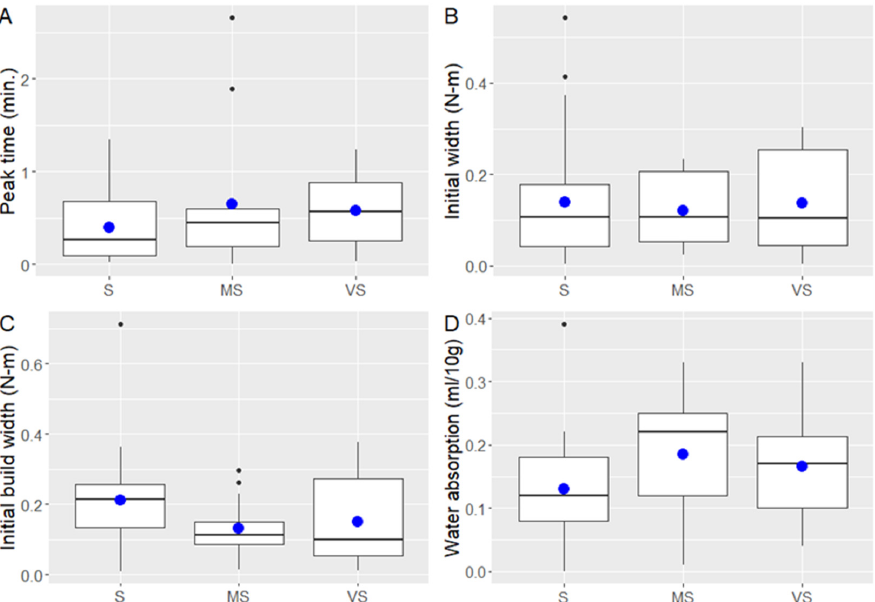
Figure 1. Differences (subtracted between the years) in the dough mixing parameters of 56 spring wheat genotypes grown in the cool (2017) and heat–drought (2018) years: peak time ( A ), initial width ( B ), initial build width ( C ), and water absorption ( D ). Peak time is expressed as minutes (min.), initial width and initial build width are expressed as mixing torque in N·m, water absorption is expressed in ml/10 g of flour. Blue dots represent mean values.